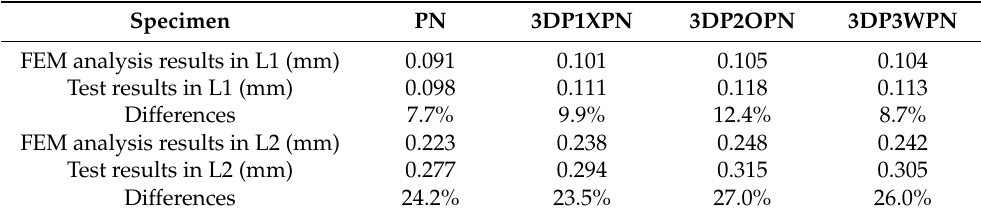
Figure 18. Wind pressure–displacement diagram of FEM analysis and lateral load test. Table 10. Differences between FEM analysis and lateral load test